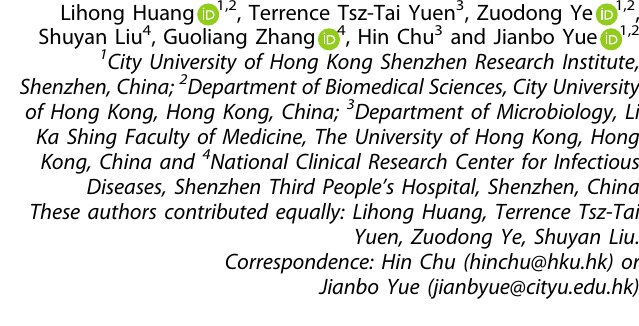
Fig. 1 Berbamine inhibits SARS-CoV-2 infection by compromising TRPMLs-mediated endolysosomal traf fi cking of ACE2. a Berbamine (10 μ M) inhibited the entry of lenti-SARS-CoV-2 S pseudotyped particles into hACE2-overexpressed HEK293T cells. b Vero-E6 cells were treated with berbamine at the indicated concentrations for 3 h, and then they were then infected with SARS-CoV-2 (~0.01 MOI). The cell lysates were collected and subjected to RT-PCR quanti fi cation of SARS-CoV-2 RNA. c Huh7 cells, treated with or without berbamine (10 μ M), were fi rst incubated with an ACE2 antibody on ice for 90 min, and the internalization of the ACE2-antibody complex was then initiated at 37 °C for the indicated times, followed by LAMP1, and DAPI staining and confocal imaging. The colocalization ef fi ciency between ACE2 and LAMP1 was quanti fi ed. d Huh7 cells were treated with or without berbamine (10 μ M) for 24 h, and the live cells were immunolabeled with the anti-ACE2 antibody, followed by FACS analysis to measure the cell surface ACE2 levels. e , f EVs were collected from the culture medium of control or berbamine (10 μ M)-treated Huh7 cells in the presence or absence of GW4689, and their concentration and distribution of sizes were determined with a nanoparticle tracking analyzer ( e ). The levels of ACE2, DPP4, TSG101, and CD63 in these EVs were determined by immunoblot analysis ( f ). g Berbamine (BBM) signi fi cantly inhibited the ML-SA1-induced cytosolic Ca 2 + increase in GECO-TRPML1-expressing HEK293T cells. h Cells were transfected with siRNA pools against all TRPMLs for 48 h, and the cell lysates were then subjected to ACE2 immunoblot analysis. i TRPMLs knockdown signi fi cantly inhibited the cell surface ACE2 levels in Huh7 cells as determined by FACS analysis. j , k EVs were collected from the culture medium of control or TRPMLs-knockdown Huh7 cells, and their concentration and distribution of